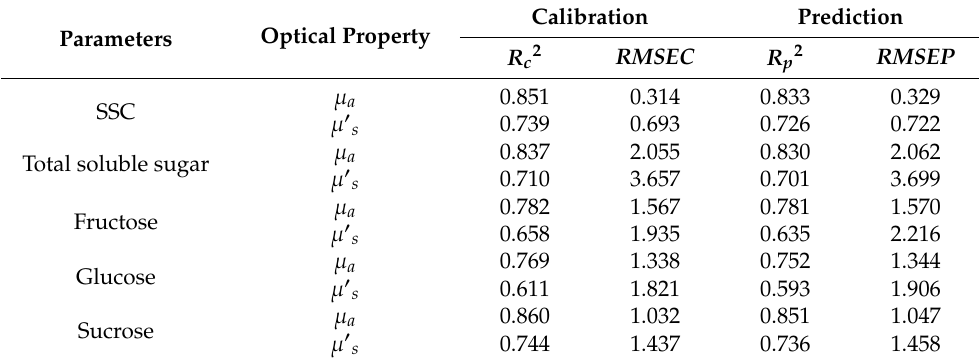
Table 4. Model results of soluble solid contents and soluble sugar contents for apples.